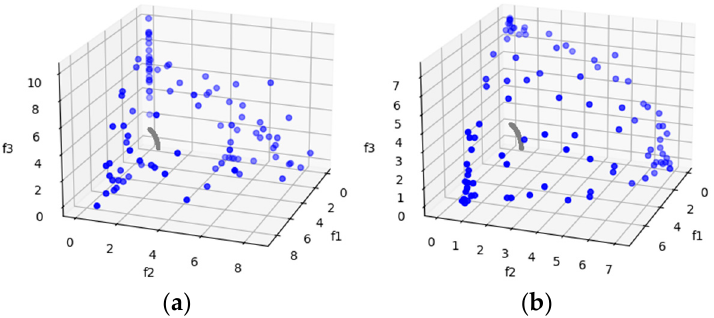
Figure 6. The plots of the approximate PFs with the highest HV value against real PF. ( a ) DTLZ5 approximate PF using MOSA/D-CGO; ( b ) DTLZ5 approximate PF using MOSA/D-DE. DTLZ6 is a more complex test problem derived from DTLZ5. It allows us to observe Figure 7. The plots of the approximate PFs with the highest HV value against real PF. ( a ) DTLZ6 approximate PF using MOSA/D-CGO; ( b ) DTLZ6 approximate PF using MOSA/D-DE.